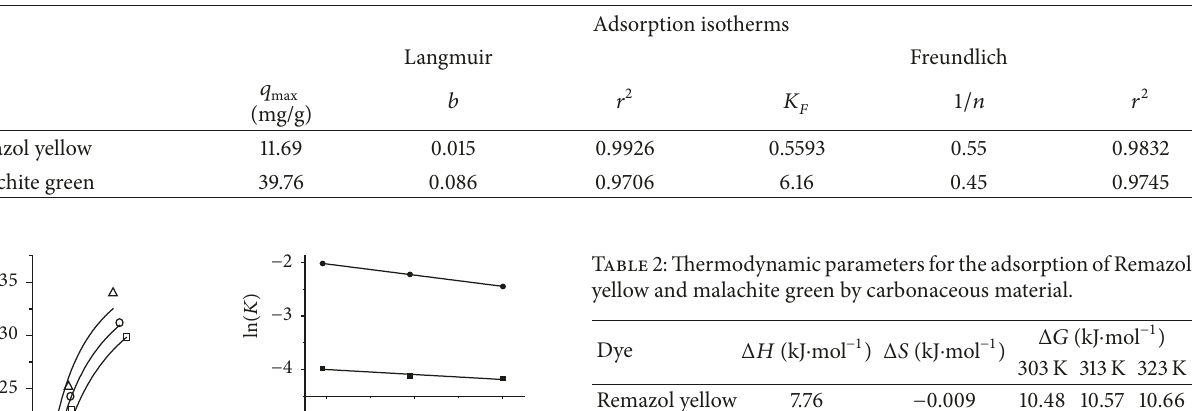
Table 1: Adsorption isotherm parameters of Remazol yellow and malachite green by carbonaceous material.